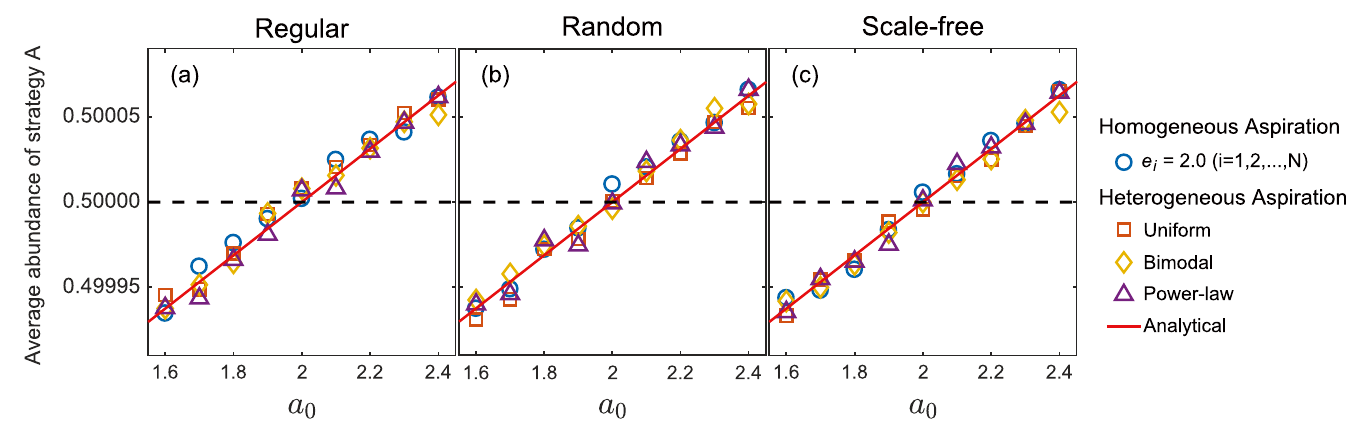
Fig 2. Average abundance of strategy A as a function of the payoff entry a 0 . Our simulation results clearly show that strategy A is more abundant than strategy B if a 0 is approximately greater than 2.0 for regular networks ( k = 2) (Panel (a)). This is in perfect agreement with our calculation based on the theorem, i.e., inequality a 0 + 2 a 1 + a 2 > b 0 + 2 b 1 + b 2 with a 1 = 2, a 2 = 1, b 0 = 4, b 1 = 1 and b 2 = 1. Note that the criterion a 0 > 2 is valid for aspiration across various distributions. It implies that the criterion to favor one strategy over the other is independent of the individualised aspiration, as stated in the theorem. Furthermore, the criterion also holds beyond regular networks (Panel (a)), namely, on random (Panel (b)) and scale-free networks (Panel (c)). It suggests that the criterion can be extrapolated to general population structures. The details of the simulations are as follows: The minimum degree of all the networks is set to be two such that all the individuals have enough neighbours to play the three-player game with. Personal aspirations are randomly assigned in a population with homogeneous aspiration e population with heterogeneous aspirations generated based on uniform distribution on the interval [0, 5] (red □ ), bimodal distribution with e 0 : 6 N ð 4 : 5 ; 0 : 5 2 Þ (orange ^ ), and power-law distribution with probability density function f ( x ) = 2 x −3 (purple 4 ). Here, N ð 2 : 5 ; 0 : 5 2 Þ stands for the normal distribution with mean 2.5 and standard deviation 0.5. In addition, the minimum value of aspiration sampled from the power-law distribution is 1.0. In the beginning, we randomly set 45% of the population to be of strategy A and the rest to be of strategy B . At each time step, the focal individual randomly chooses two individuals from its neighborhood and play a single three-player game with them to obtain the payoff. Fermi function is employed as the decision making function for all the individuals. Each data point is the mean of the average abundance of strategy A calculated from three independent runs (5 × 10 9 samples in each run, 1.5 × 10 10 samples in total). In each run, we start sampling after a relaxation time of 5 × 10 7 time steps. The average abundance of strategy A is obtained by averaging the abundance of strategy A over 5 × 10 9 time steps. The population size N = 1000. The selection intensity β =